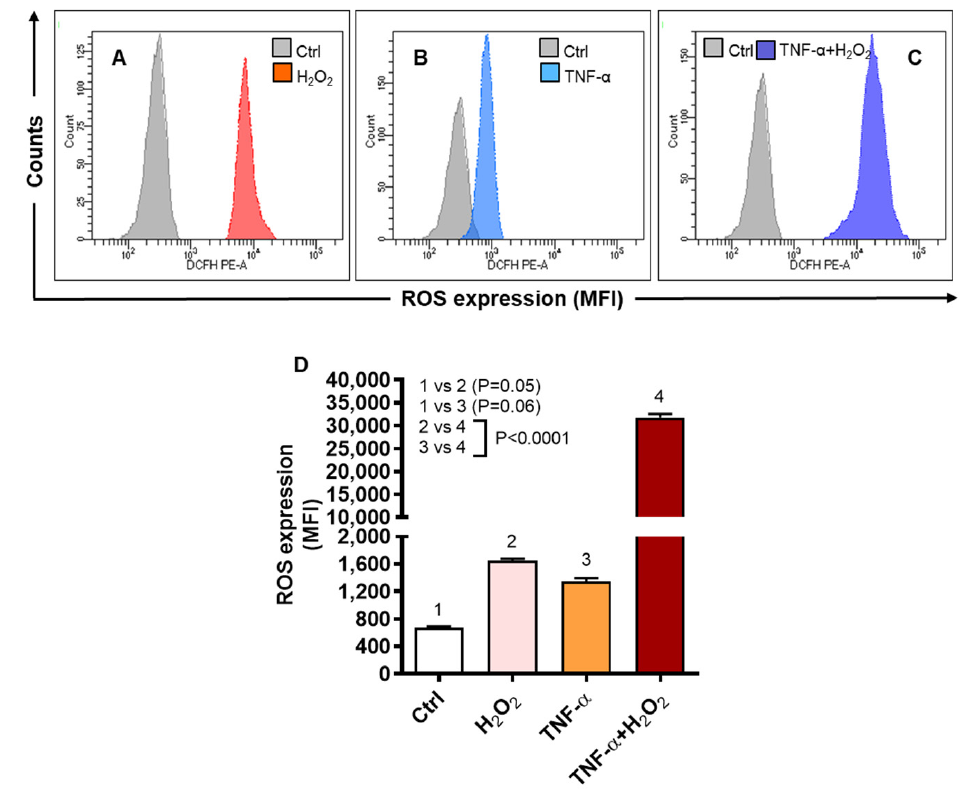
Figure 5. TNF- α /H 2 O 2 cooperativity promotes the intracellular ROS expression. THP-1 cells were stimulated, in triplicate, with TNF- α (10 ng/mL) and/or H 2 O 2 (10 mM), while control cells were treated with vehicle only. ROS expression was determined by using DCFH-DA assay and DCF expression, shown as mean fluorescence intensity (MFI), was measured by flow cytometry as described in materials and methods. One-way ANOVA (Tukey’s multiple comparisons test) was used to calculate group differences and p -values less than 0.05 were considered as significant. The representative histograms from three independent experiments with similar results show ( A – C ) comparative ROS expression in cells stimulated with TNF- α and/or H 2 O 2 versus control. ( D ) Quantitative analysis of flow cytometry data (MFI: mean ± SEM) shows significantly elevated ROS expression in THP-1 cells co-stimulated with TNF- α and H 2 O 2 , compared to stimulation with either TNF- α or H 2 O 2 ( p < 0.0001).